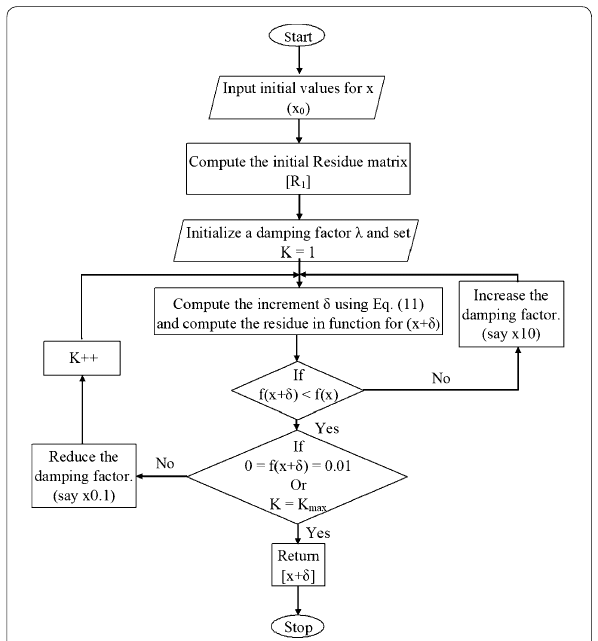
Figure 5 Flowchart for Levenberg–Marquardt Algorithm